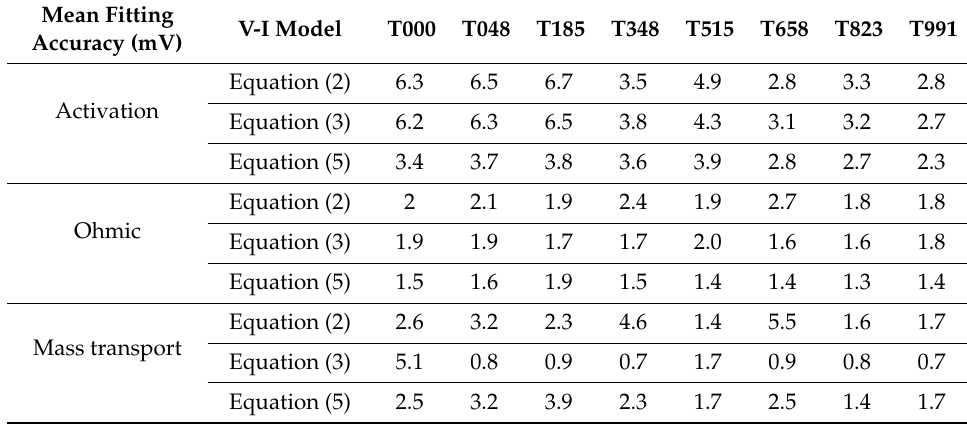
Table 4. Fitted model parameters in Equation (2).